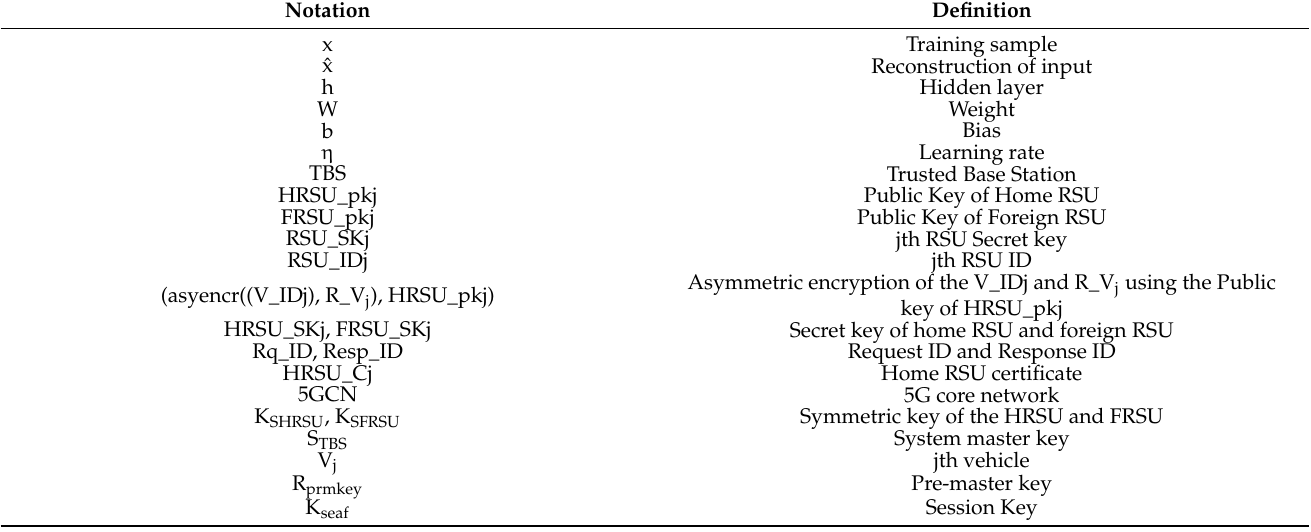
Table 2. Notations